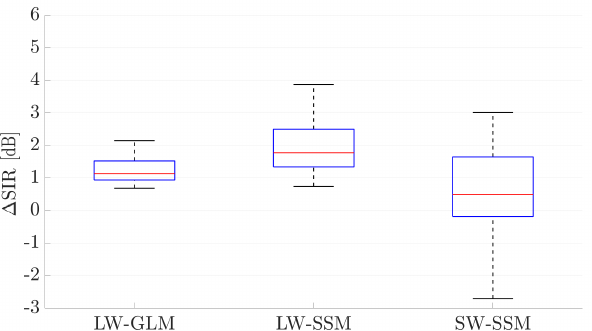
Figure 8. SIR improvement of the proposed cognitive-driven gain controller system when using the LW–GLM, LW–SSM, and SW–SSM algorithms. The boxplots display the median, the first quartile, the third quartile, the minimum, and the maximum of the SIR improvement across